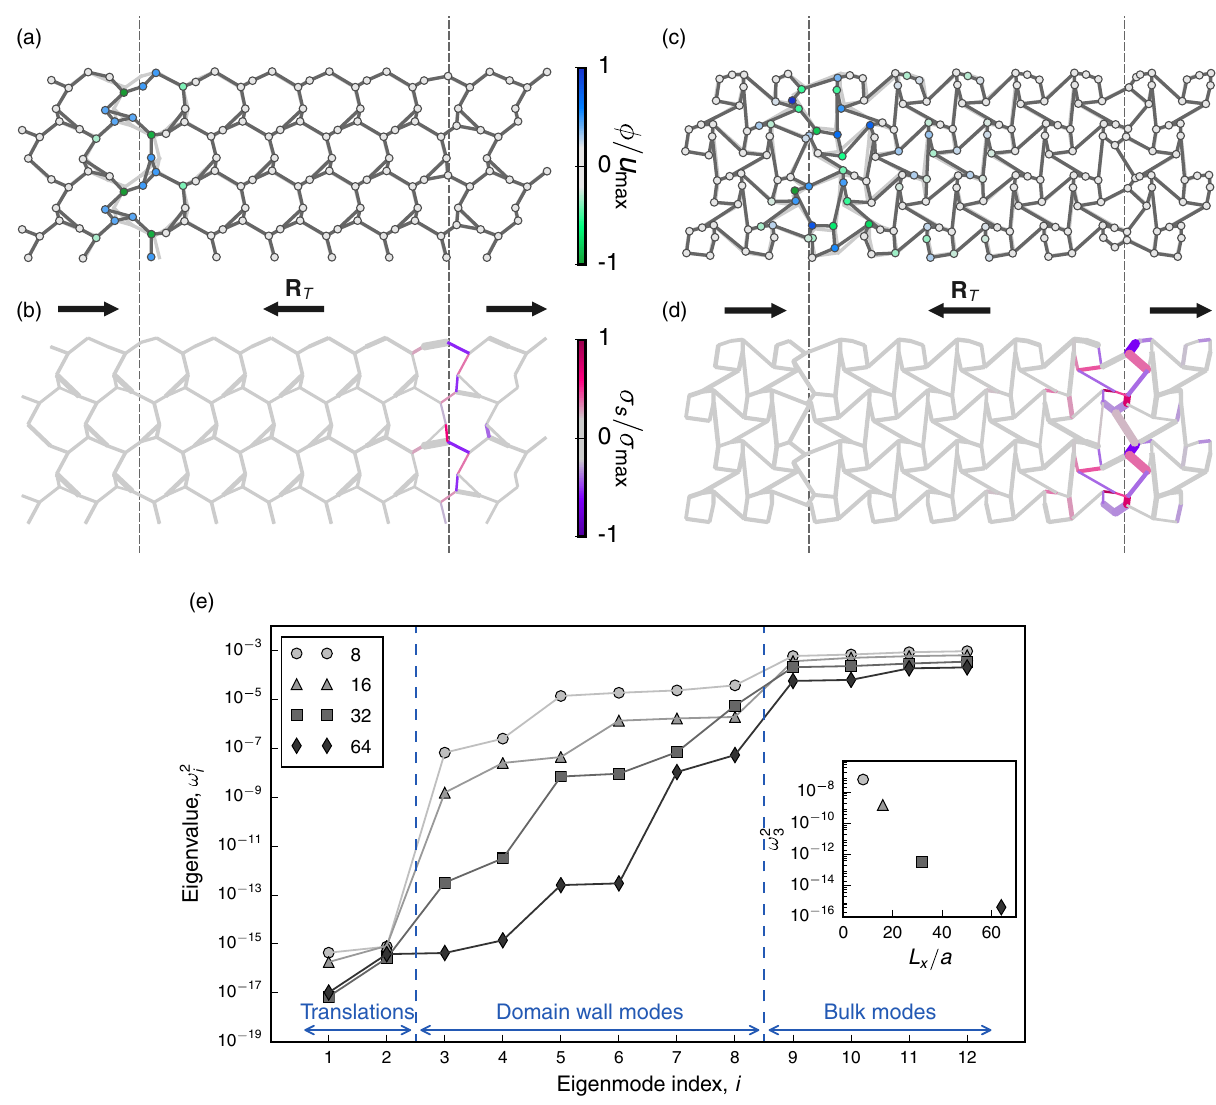
FIG. 7. Topological modes and states of self-stress at domain walls. (a),(b) Domain walls (dotted lines) separating oppositely oriented sections of the polarized martini lattice. Although the number of degrees of freedom and constraints are unchanged along the domain walls, they localize zero-energy modes and stress states because they carry a net polarization flux. The domain wall on the left has a net influx of polarization and localizes zero modes. In finite systems, these become soft modes and stress states with energy exponentially small in system size, one of which is visualized in (a). The dark lines show a lattice with nodes moved in proportion to the displacement components of the zero eigenvector, and colored by the torsional components. The light gray lines show the undeformed lattice for comparison. The domain wall on the right has a net outflux of polarization and localizes states of self-stress, one of which is visualized in (b). Bonds are colored by the shear components of the zero stress eigenvector, and their thicknesses are proportional to the tension components. (c),(d) Same as in (a),(b) for the polarized deformed hexachiral lattice. (e) System size dependence of the localized mode energies. The lowest eigenvalues of the dynamical matrix are shown as a function of system length along the horizontal direction for the domain wall geometry of (a) and (b), with domain walls always placed 0 . 66 L x apart. Inset: Eigenvalue of the first nontranslation mode (index i ¼ 3 ) as a function of system